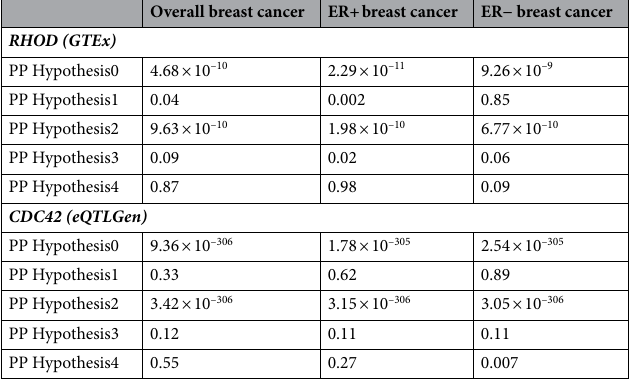
Table 3. Results of colocalisation analyses for RHOD and CDC42 genes. nsnp number of SNPs used in the analysis, PP posterior probability.